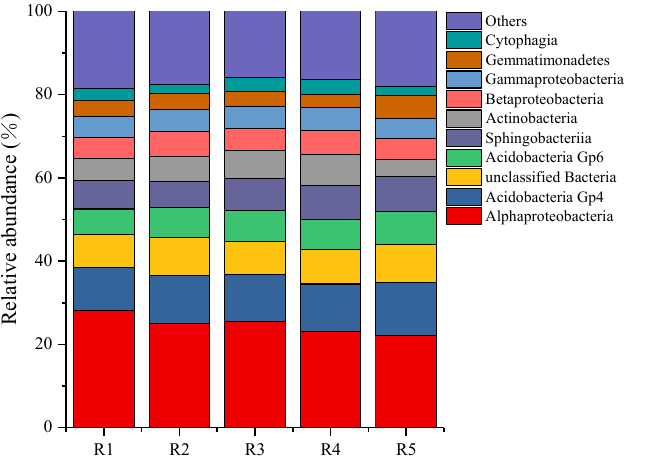
Figure 3. The relative abundance of bacterial community composition in classes level. R1, R2, R3, R4, and R5 represent planting years for 1, 2, 3, 4, and 5 years, respectively. At the bacterial genus level (Figure 4), Sphingomonas (6.68–10.43%), Gp4 (6.61– 8.58%) and GP6 (6.11–7.87%) were the top three bacterial genera in all rhizosphere soils. The other major bacterial genera were Gemmatimonas (3.04–5.53%), WPS-1 genera incer- tae sedis (1.10–2.81%), Gp7 (1.25–1.76%), Subdivision3 genera incertae Sedis (1.28–1.69%), and Aridibacter (1.02–1.72%). With the increase of continuous cropping years, the relative abundance of Sphingomonas decreased gradually, while the relative abundance of Gp4 and GP6 increased gradually. Figure 4. Microbial community heatmap and cluster analysis of the bacterial community composi- tion in genus level. R1, R2, R3, R4, and R5 represent planting years for 1, 2, 3, 4, and 5 years, respec- tively.